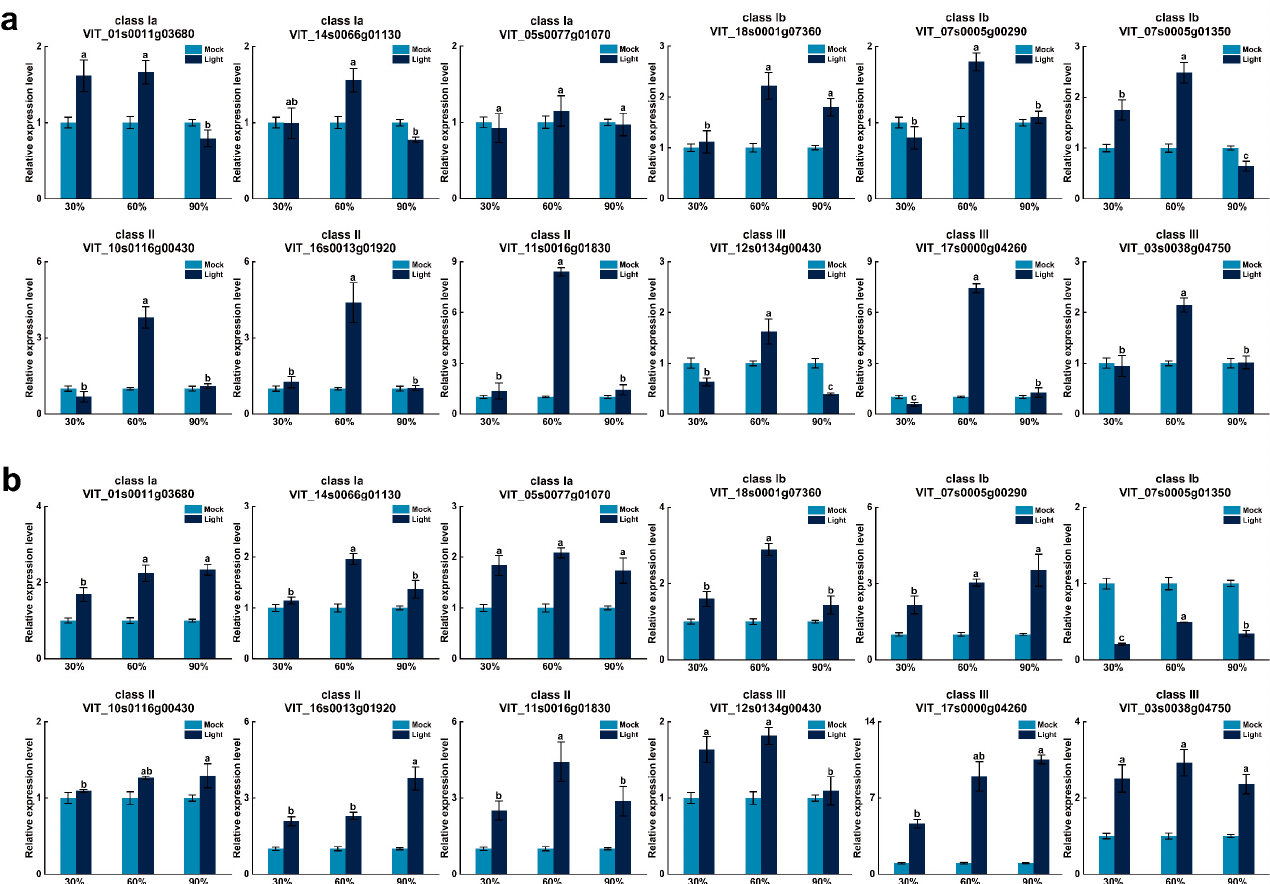
Figure 7. Expression levels of VvUSP genes at 20 days ( a ) and 40 days ( b ) of low-light-stress treatments by qRT-PCR. Different letters above the bars indicate a significant difference ( p < 0.05). Salt stress is one of the main abiotic stress factors that restrict crop productivity and quality. About 20% of irrigated farmland imposes salt stress on plant growth, with effects on crop growth [38]. Due to improper irrigation and the use of chemical fertilizer, second- ary salinization of soil is becoming more problematic, reaching 2–8 g·L − 1 in some